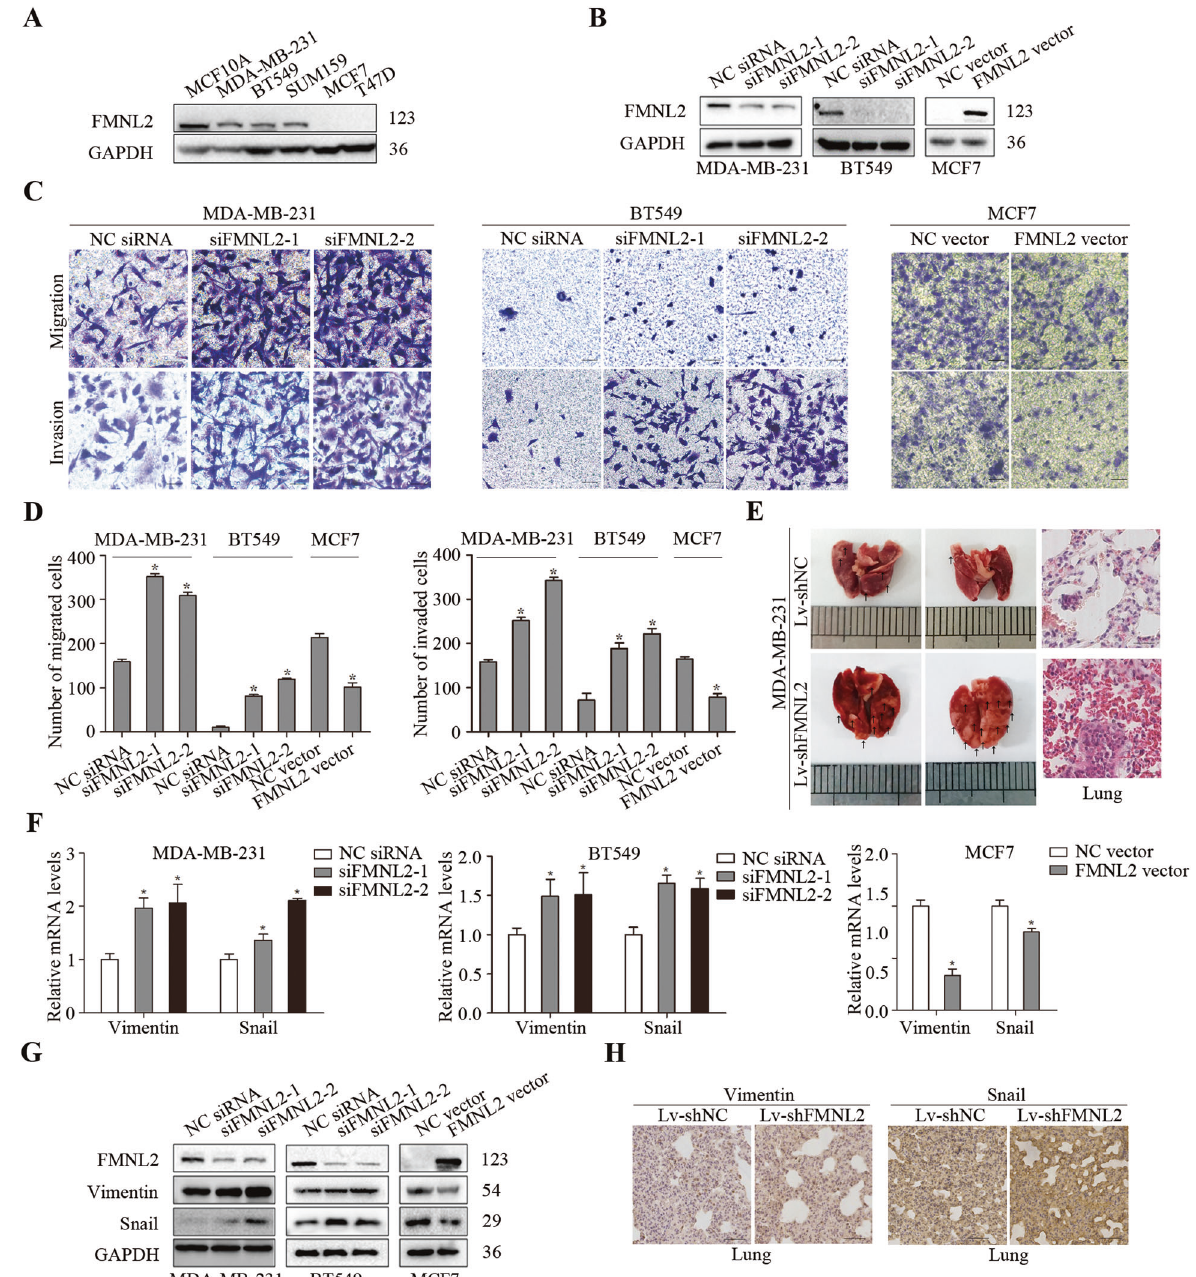
Fig. 1 Effects of FMNL2 on cell migration and invasion of breast cancer in vitro and in vivo. After transfection for 48 h, cultured cells were processed for indicated assays. A The protein levels of FMNL2 were measured by western blotting in human breast cancer cells. B The silencing ef fi ciency and overexpression of FMNL2 were measured by western blotting in human breast cancer cells. C , D Representative images and quanti fi ed data of transwell assay were shown. Scale bar, 50 μ m. E Representative lung metastasis in mice and HE staining of lung sections. Scale bar, 35 μ m. F , G The levels of Vimentin and Snail were examined using qRT-PCR and western blotting. H The IHC staining for Vimentin and Snail in lung tissues was shown. Scale bar, 50 μ m. * P < 0.05 versus corresponding control